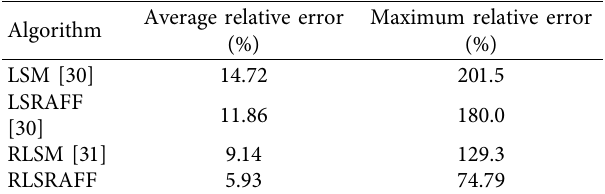
estimated value and the true value of system